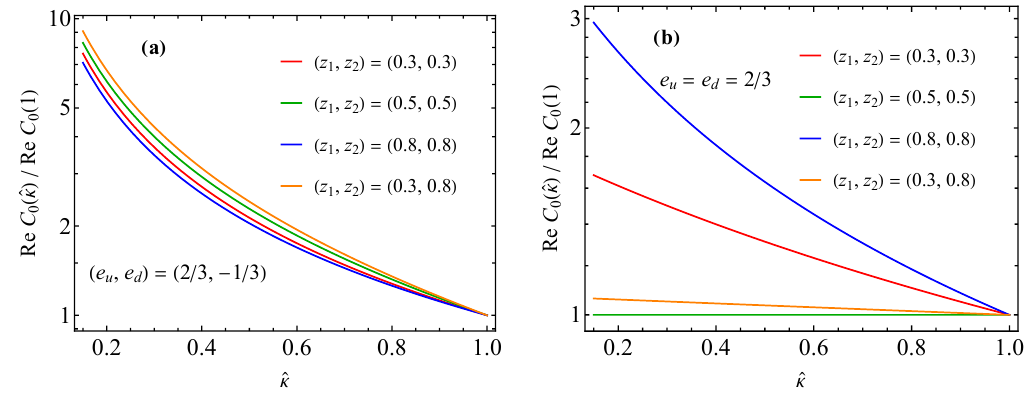
Figure 28. The shapes of ˆ κ distribution in Re C 0 in eq. (A.4), normalized to its value at ˆ κ = 1